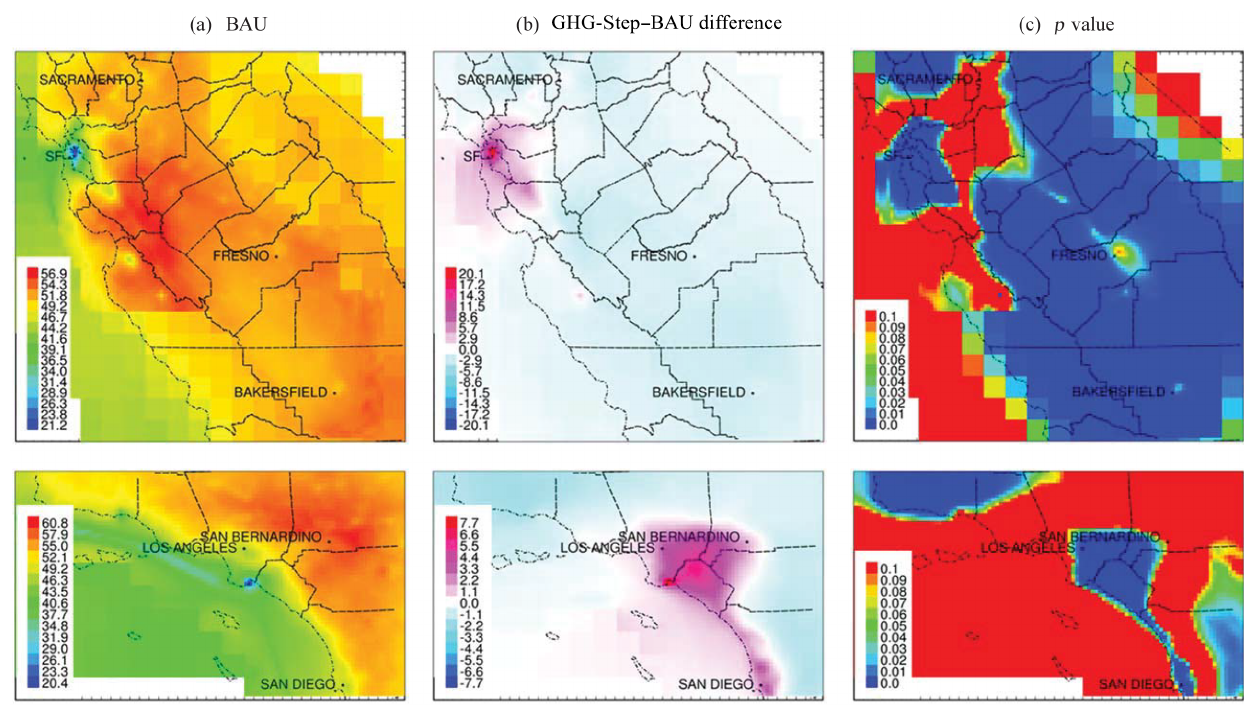
Figure 3. (a) Annual average of daily 8h average ozone concentration (ppb) under the BAU scenario, (b) change in 8h average ozone concentrations (ppb) under the GHG-Step scenario, and p -value significance level of the difference between concentrations predicted using the BAU and GHG-Step scenarios. All simulations for the year 2054. Both 24km resolution results and the finer 4km resolution results are shown, with the finer, smaller southern California or central-northern California domains overlaid upon the coarse California domain